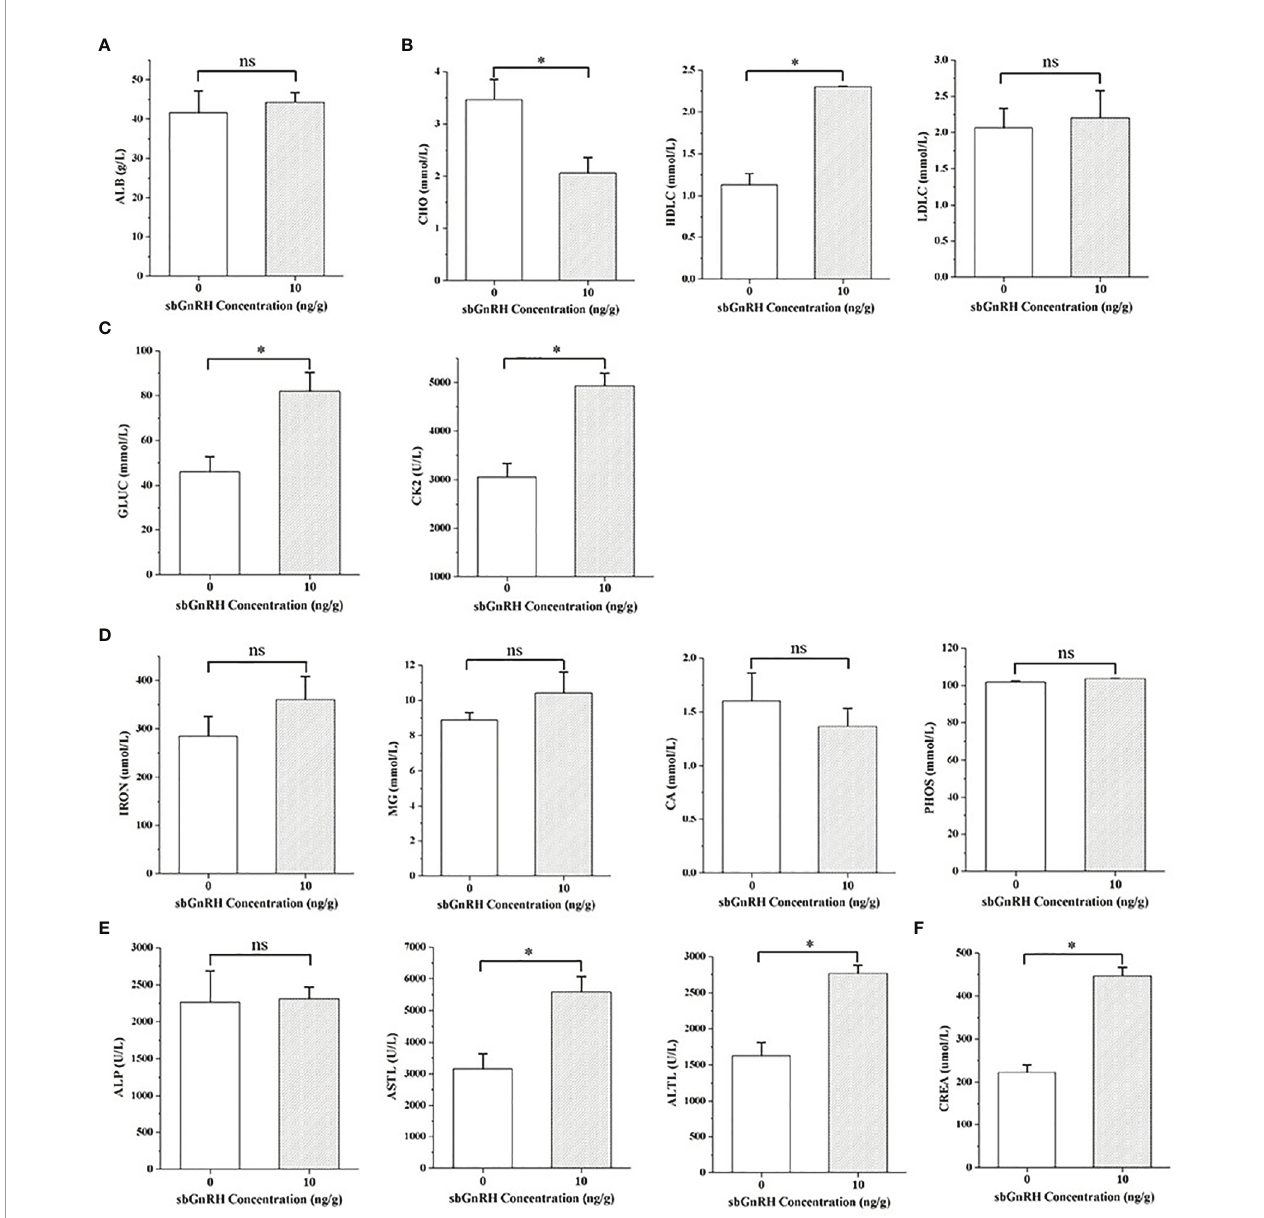
FIGURE 1 | Comparative evaluation of physiological and biochemical indexes in the liver of pompano. (A) protein metabolism; (B) lipid metabolism; (C) energy metabolism; (D) inorganic component; (E) liver function; (F) renal function. Data are expressed as mean ± standard error (SE) (n = 3), and the statistical signi fi cance (compared with the control group) was calculated using one-way analysis of variance (ANOVA), followed by Duncan ’ s post hoc test. * indicate statistical differences at P < 0.05, respectively. ns, not signi fi cant ( P >